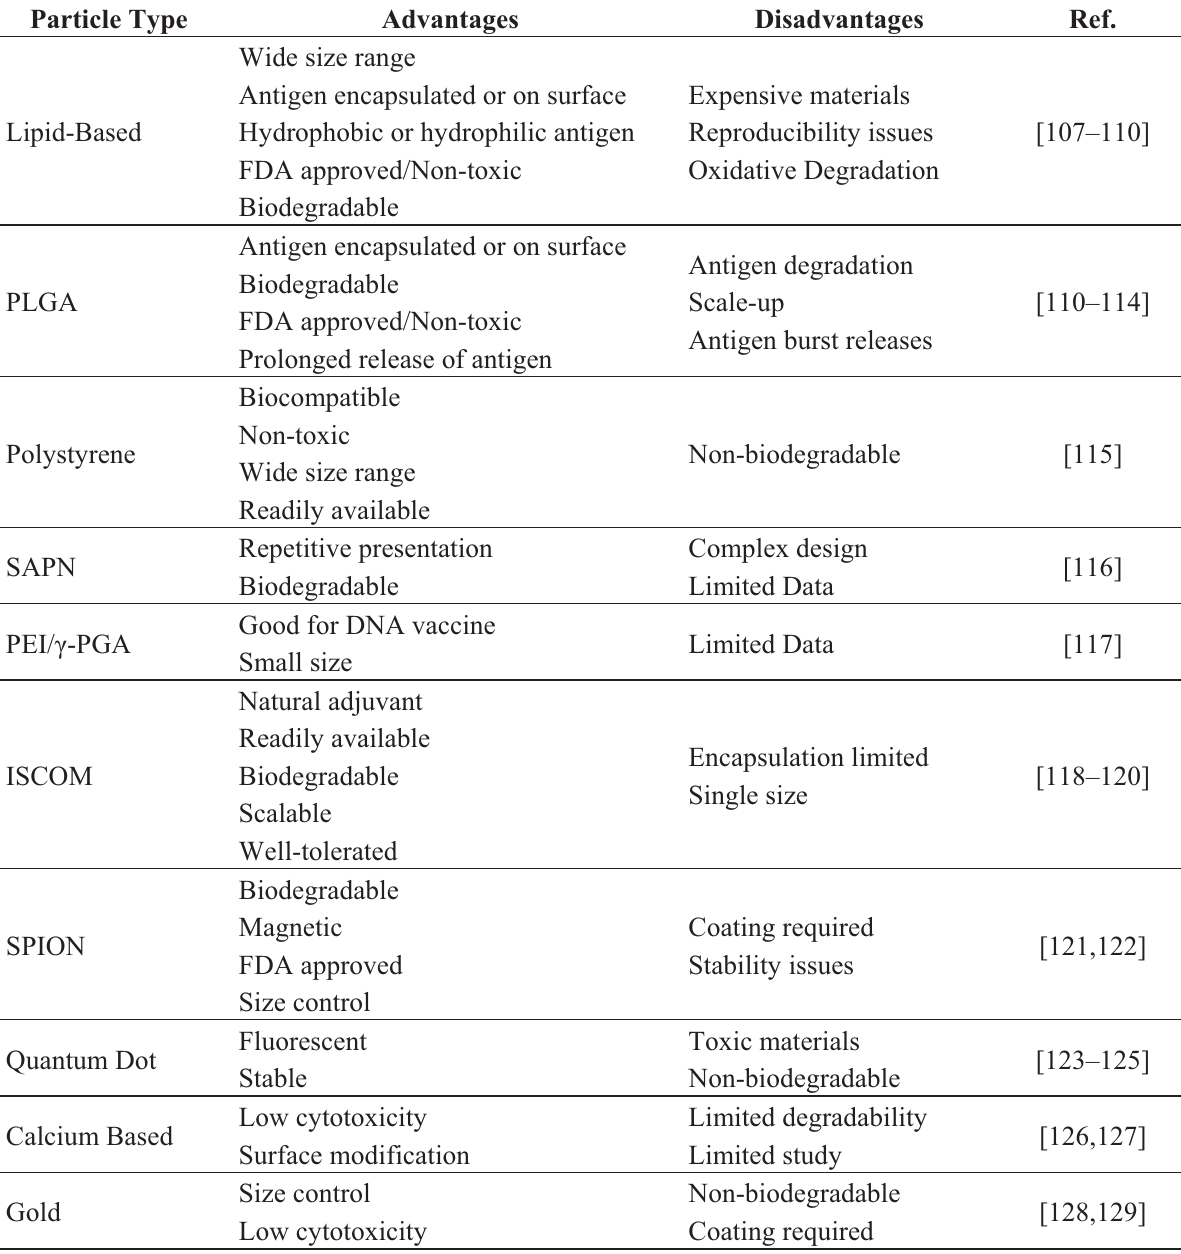
Table 2. Comparison of advantages and disadvantages of different nanoparticle